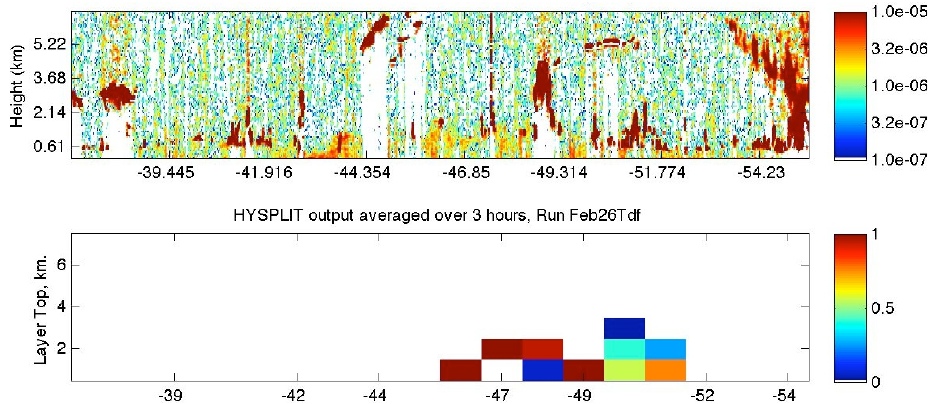
Fig. 10. Same as Fig. 8 but for 27 February. Note that the location of highest backscattering seen by GLAS in the boundary layer ( ∼ 44S) Figure 10: Same as figure 8 but for February 27. Note that the location of does not coincide with location of the dust modeled by highest backscattering seen by GLAS in the boundary layer (~44S) does not coincide with location of the dust modeled by HYSPLIT.